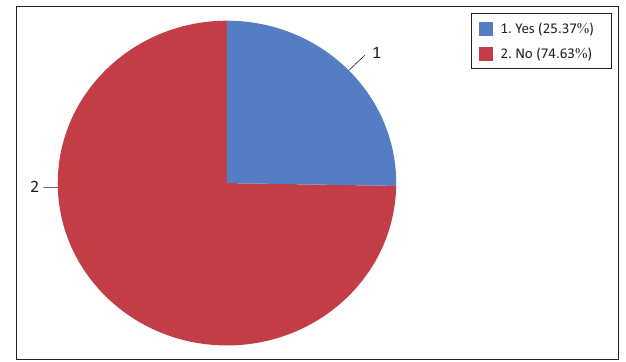
FIGURE 2: The number of readers who attended the book club meetings in 2013.